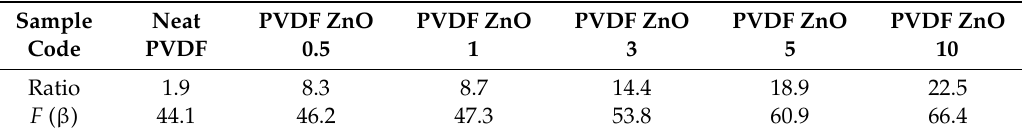
Figure 5. FTIR spectra for neat PVDF and the PVDF ZnO star-like composite films with various filler contents. Table 1. Summarized values of the relative ratio between the intensities corresponding to α - and β -phase and the calculation of the β -phase according to Equation (5).